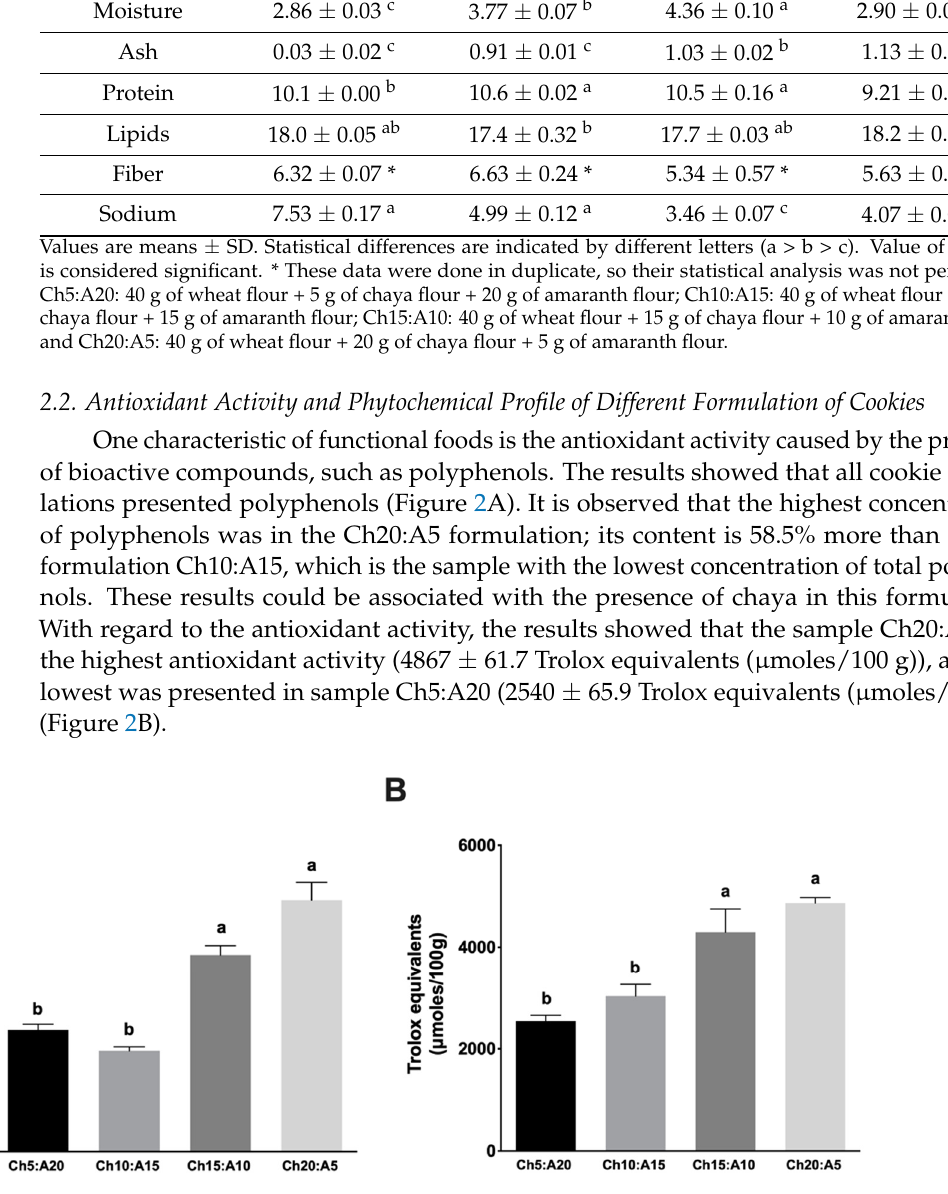
Figure 2. Total polyphenols and antioxidant activity of different formulations of cookies. ( A ) Concentration of total polyphenols. ( B ) Antioxidant activity. Values are mean ± SD. Statistical differences are indicated by different letters (a > b). Value of p < 0.05 is considered